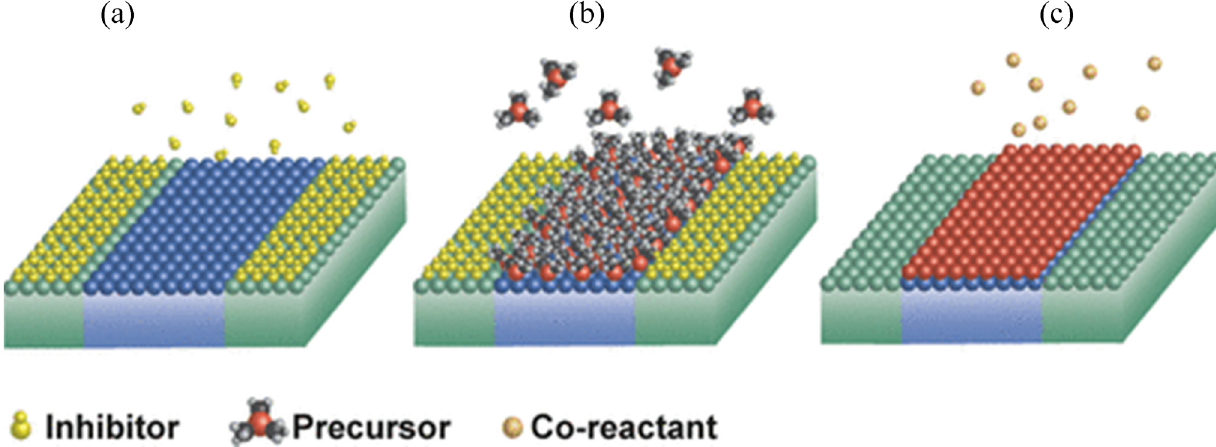
Figure 4: The ABC - type atomic layer deposition technique for ASLAD employing small inhibitor molecules. ( a ) Absorption of inhibitor molecules unto the non - growth region. ( b ) The inhibitor molecules impede the precursor molecules ’ adsorption on the non - growing region. ( c ) The co - reactant gets rid of the precursor ligands and the inhibitor molecules from the